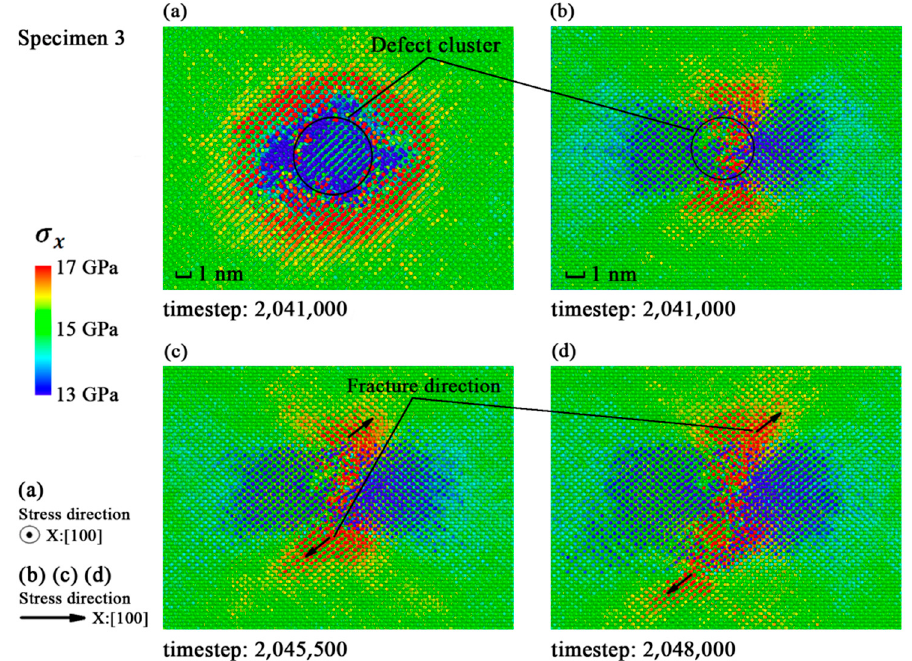
Figure 5. Distribution of σ x in specimen 3 before fracture: ( a ) Snapshot at timestep 2,041,000; ( b ) snapshot at timestep 2,041,000; ( c ) snapshot at timestep 2,045,500; ( d ) snapshot at timestep 2,048,000.